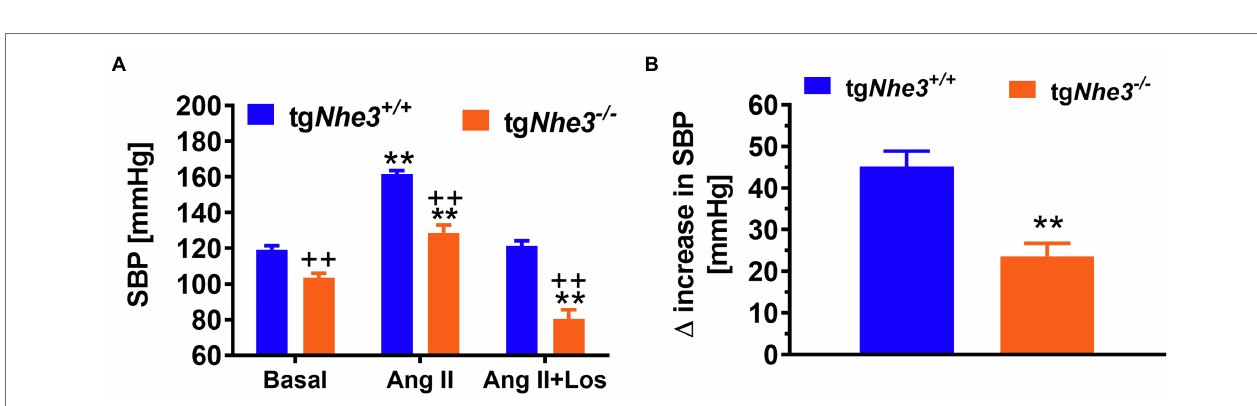
FIGURE 4 | Angiotensin II-induced hypertension is attenuated in global Nhe3 − / − mice with transgenic rescue of the NHE3 gene in small intestines using the small intestine-specific IFABP promoter, tg Nhe3 − / − (A,B) . Note that basal blood pressure remains significantly lower in tg Nhe3 − / − mice than WT mice (A) . ** p < 0.01 vs. their basal level; ++ p < 0.01 vs. WT mice. Reproduced from Li et al. (2019a) with permission from the copyright